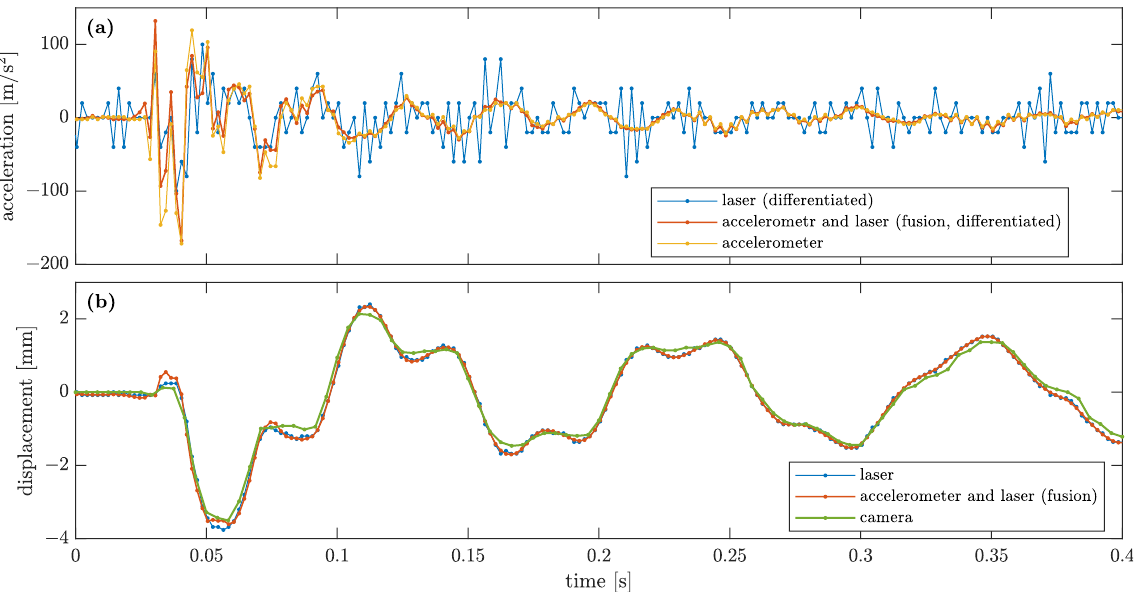
Figure 9. Comparison of ( a ) accelerations and ( b ) corresponding displacements of Node 2 obtained by various types of sensing of the structural